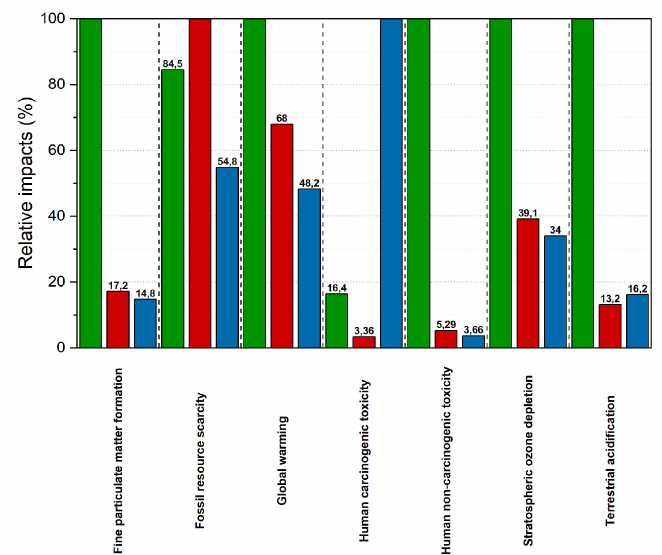
Figure 28. The histogram showing the relative impacts for the main and most reliable factors studied. Data were normalized to the maximum value for a rapid evaluation of the advantages and disadvantages of each material. Green bars refer to the impacts calculated for lead, red bars for the composite samples and blue bars are referred to steel impacts. Reprinted from